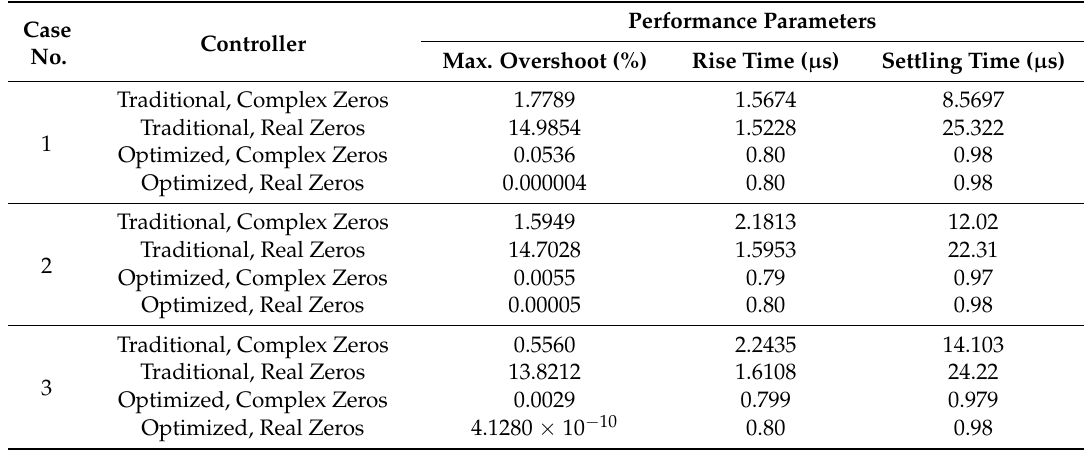
Table 3. Comparative analysis of controllers’ performance characteristics.